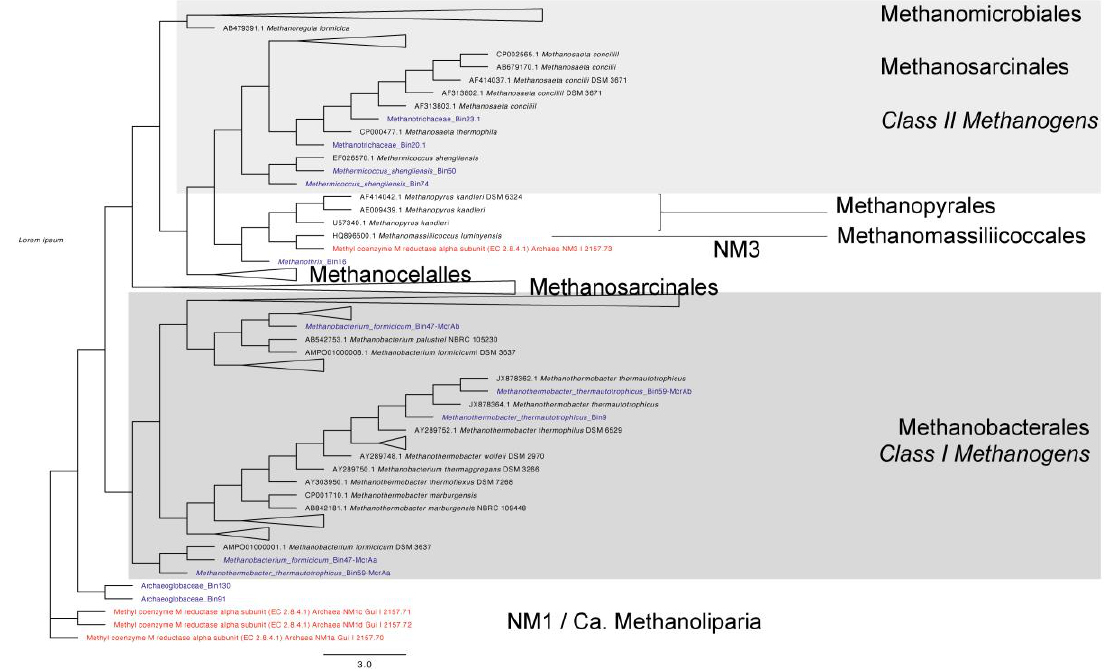
Figure 6. Phylogenetic tree of mcrA gene sequences recovered from the archaeal MAGs. Sequences of mcrA extracted from MAGs are shown in blue and Ca. Methanoliparia (NM1) and NM3 lineages are shown in red. The initial tags for mcrA sequences refer to accession numbers.